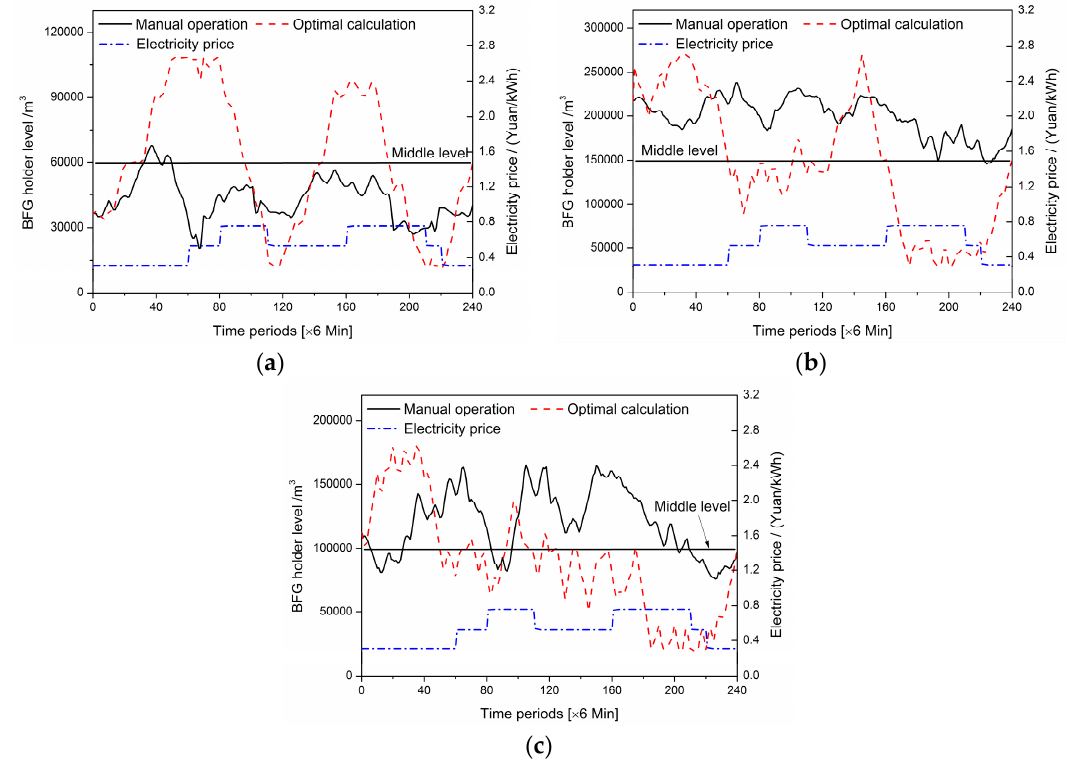
Figure 3. ( a ) Comparison of manual operation and optimal calculation results for the 120,000 m 3 (Blast furnace gas) BFG holder of plant A; ( b ) comparison of manual operation and optimal calculation results for the 300,000 m 3 (Blast furnace gas) BFG holder of plant B; ( c ) comparison of manual operation and optimal calculation results for the 200,000 m 3 (Blast furnace gas) BFG holder of plant B.